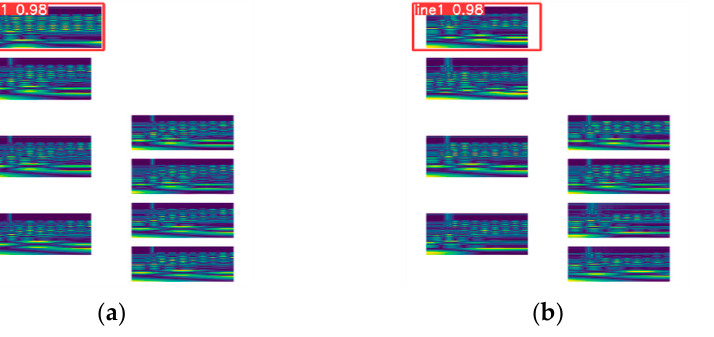
Figure 16. Grounding fault that occurred in Line 1: fault distance of ( a ) 2 km; ( b ) 4 km; ( c ) 6 km.